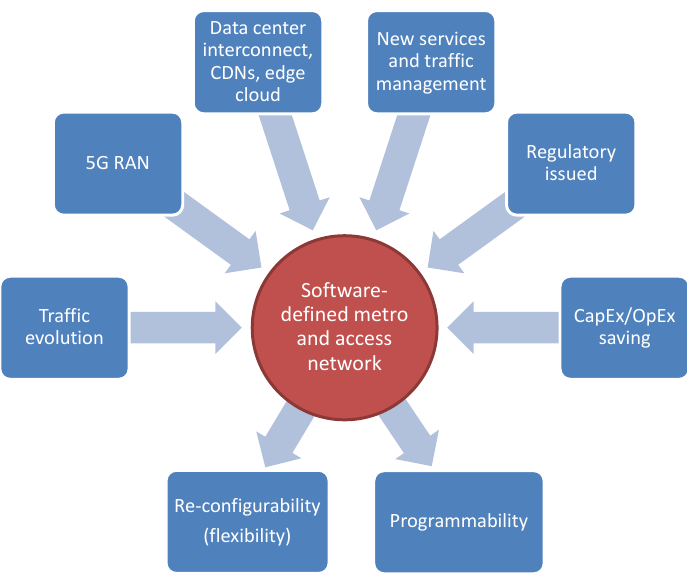
Figure 1. Main reasons for software-defined metro and access networks.